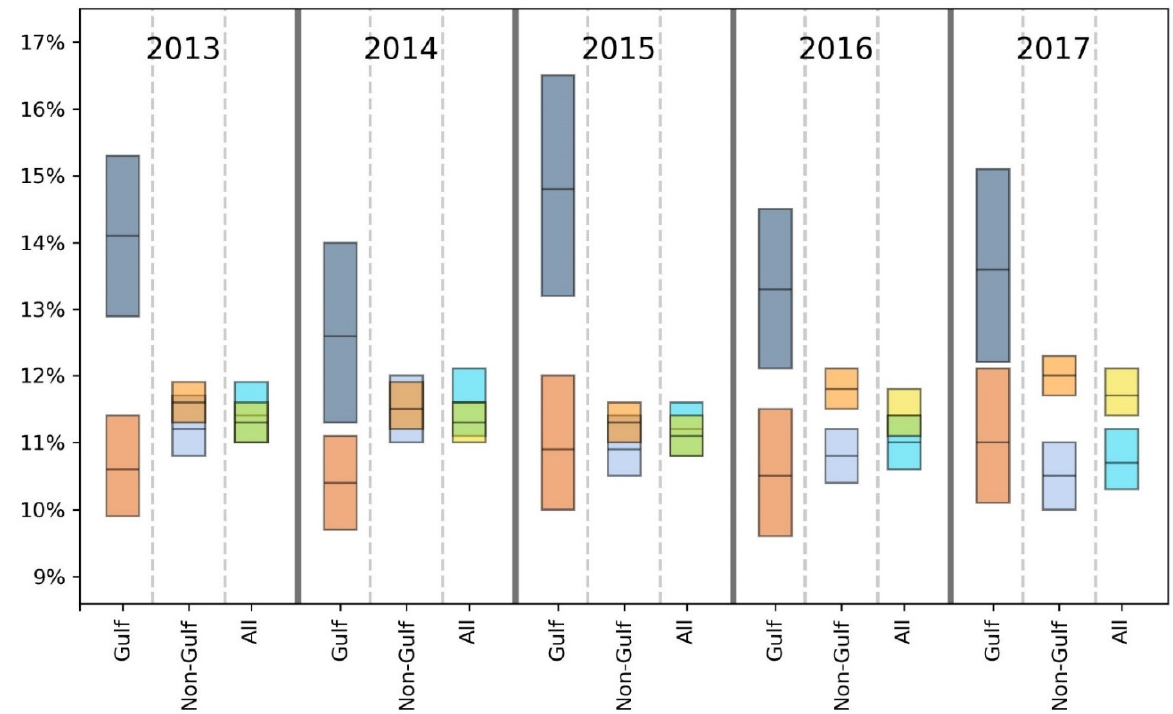
Figure 3. Comparison of mean (black line across bar) and 95% confidence intervals for percentages of Gulf and non-Gulf MMSA respondents reporting ≥ 14 physically unhealthy days out of the last 30. Colors denote the following: dark blue = coastal Gulf, light blue = coastal non-Gulf, dark orange = non-coastal Gulf, light orange = non-coastal non-Gulf, bright blue = all coastal, yellow = all non-coastal.